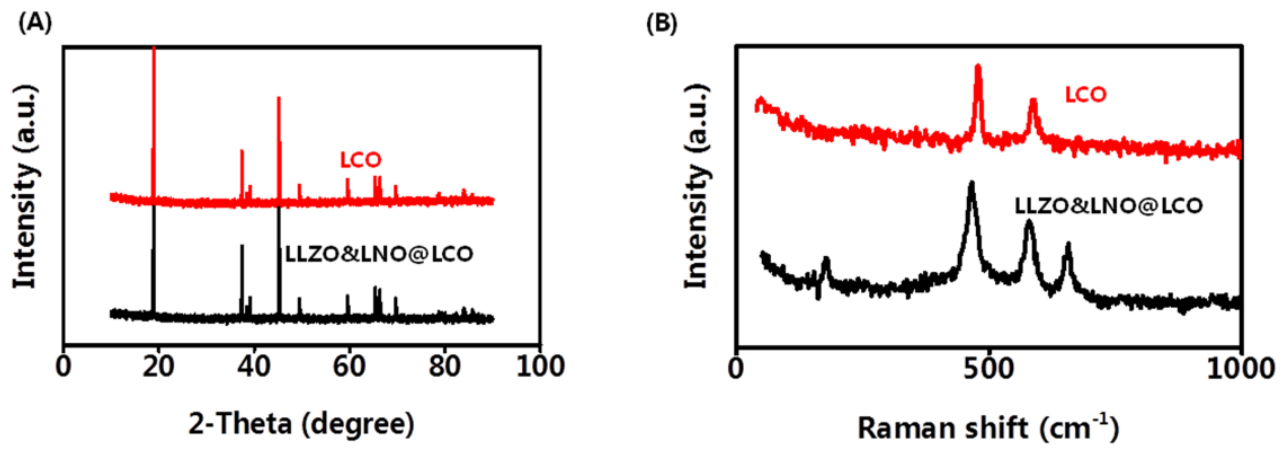
Figure 3. Elemental O, Co, Zr, Nb, and La mapping of LLZO&LNO@LCO. Figure 3. ( A ) selected particles, and elemental O ( B ), Co ( C ), Zr ( D ), Nb ( E ), and La ( F ) mapping of LLZO&LNO@LCO.